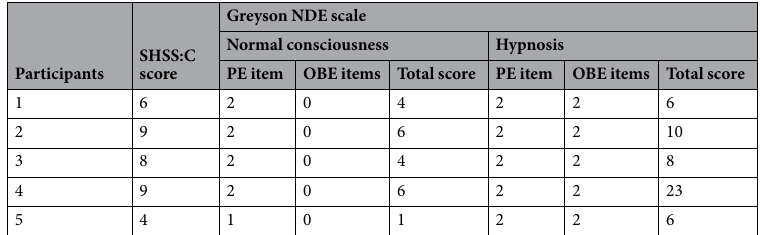
Table 1. Participants’ Stanford Hypnotic Susceptibility Scale (form C; SHSS:C) 42 total scores and responses to the Greyson NDE scale after the recall of the NDE memory in the two conditions. PE = feeling of peacefulness; OBE = out-of-body